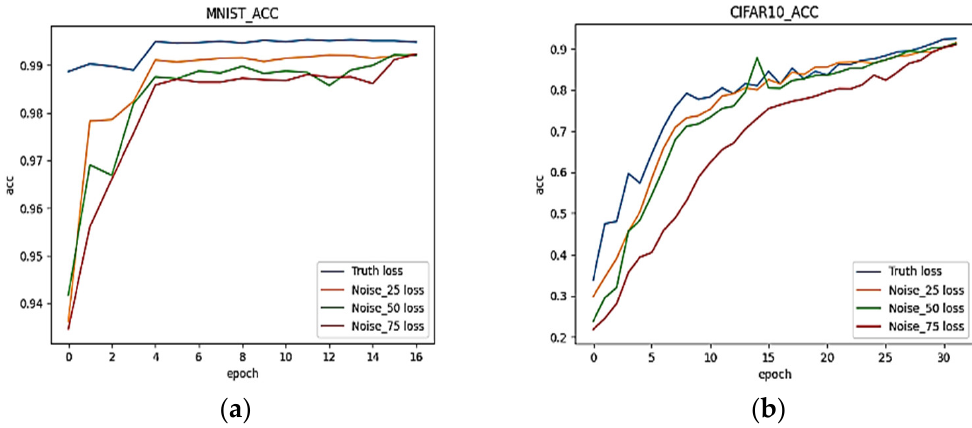
Figure 4. MNIST and CIFAR10 classification accuracy. ( a ) classification accuracy on the MNIST data set, ( b ) classification accuracy on the CIFAR10 data set. set, ( b ) classification accuracy on the CIFAR10 data set.